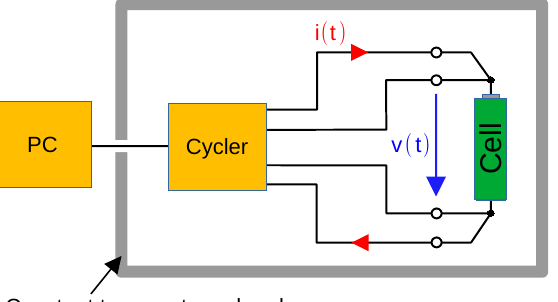
Figure 2. Schematic measurement setup: Cycler and cell are located in a temperature-stabilized box. The cell is measured using four-wire sensing to ensure good measurement precision. The cycler is controlled by a PC, so that measurement programs can be adapted and performed as